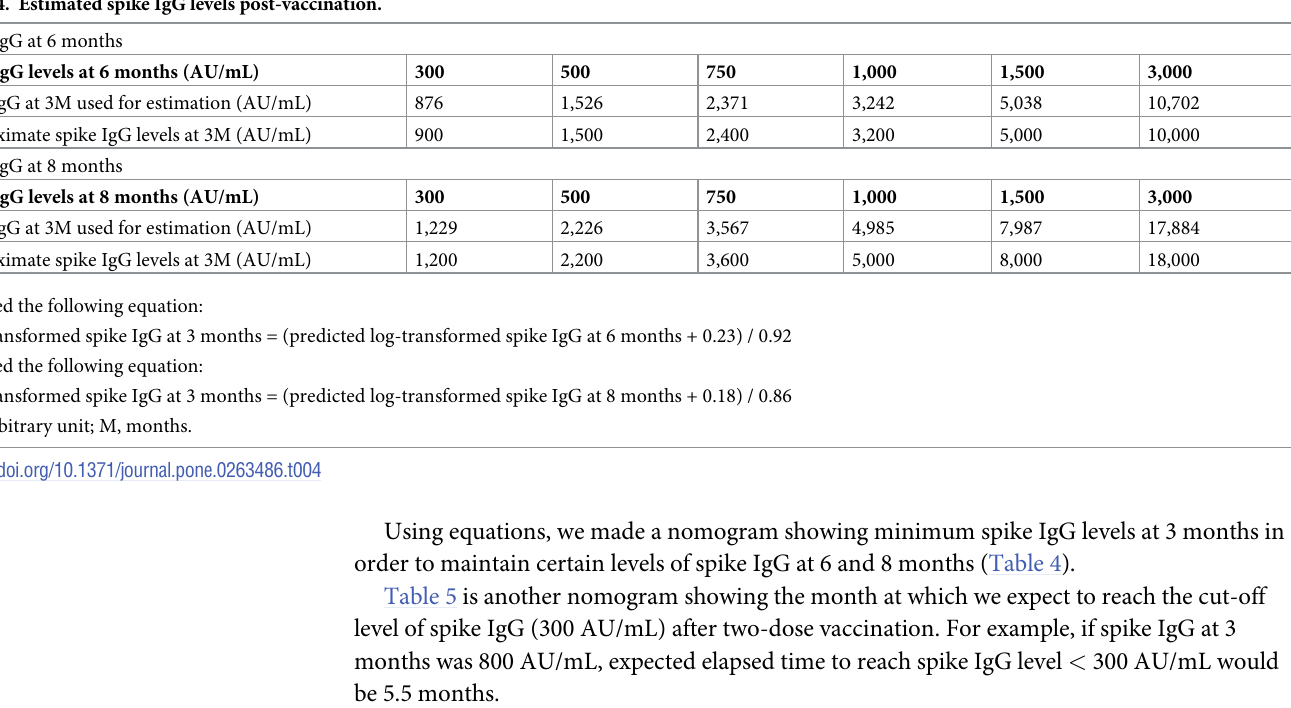
Table 4. Estimated spike IgG levels post-vaccination. Spike IgG at 6 months spike IgG levels at 6 months (AU/mL) spike IgG at 3M used for estimation (AU/mL) Approximate spike IgG levels at 3M (AU/mL)